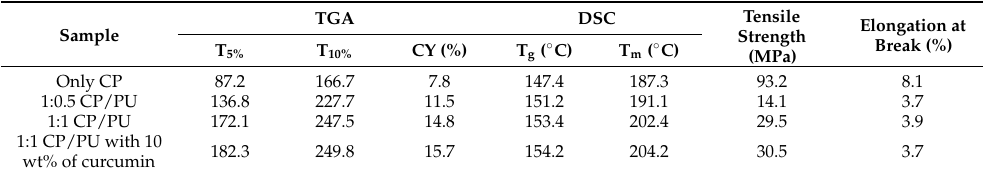
Table 2. Thermal properties, mechanical properties, WVP, and CA of the CP/PU/curcumin composite films.